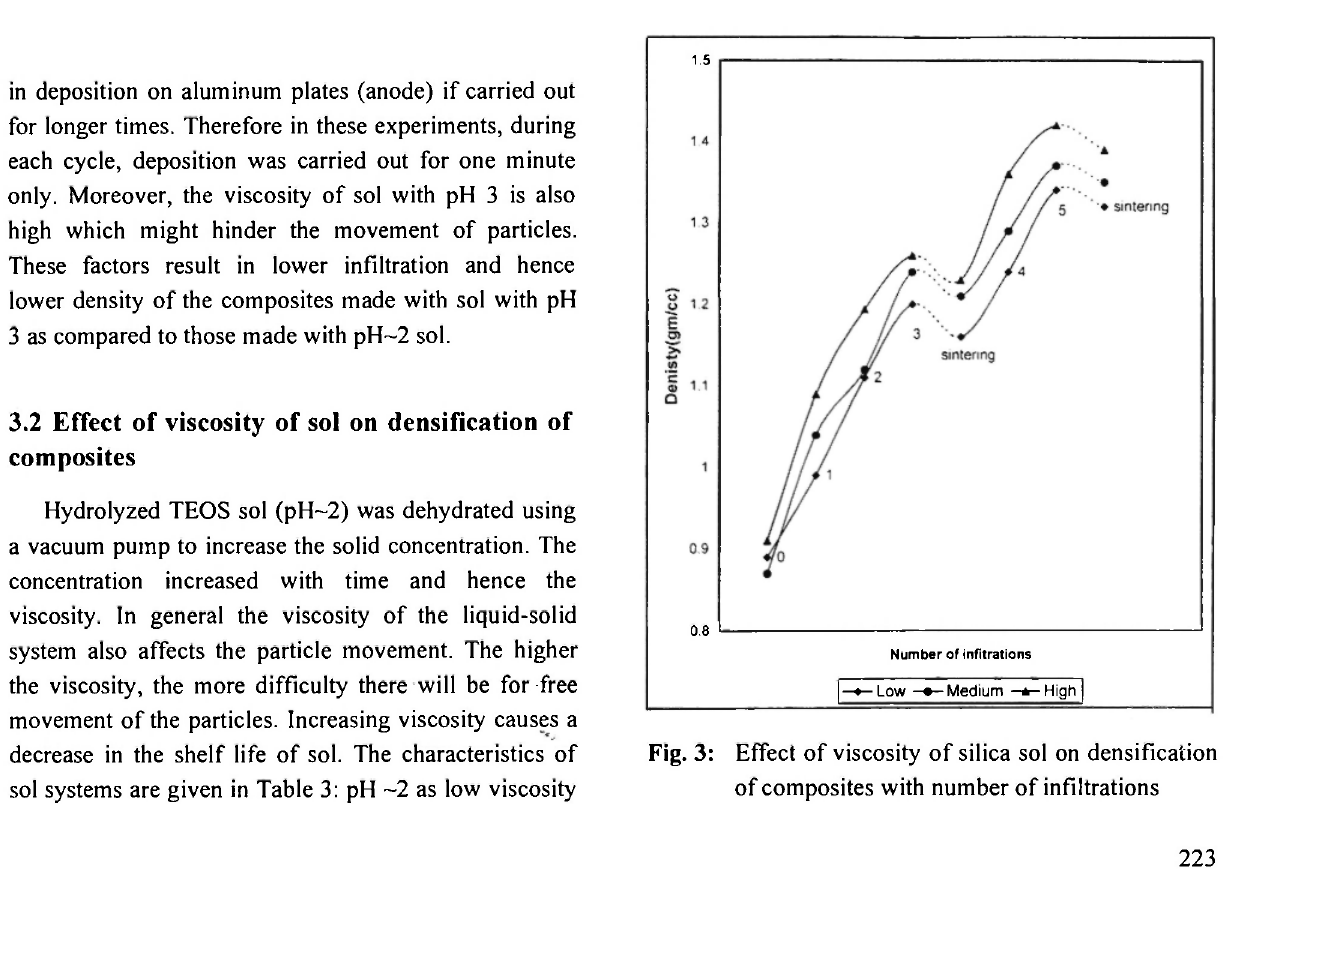
Fig. 2: Effect of pH of silica sol on densification of composites with number of infiltration cycles